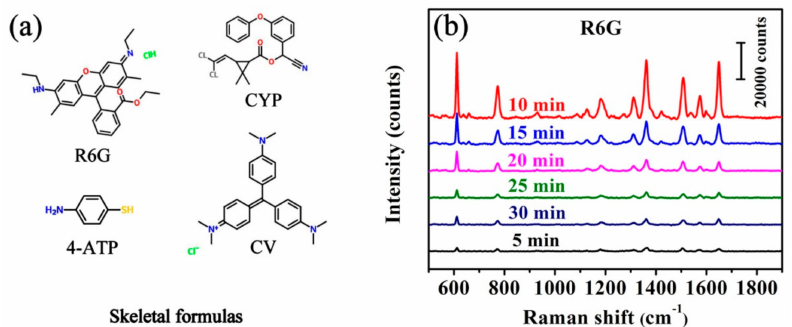
Figure 4. ( a ) The Skeletal formulas of the probe molecules used in this study; and ( b ) SERS spectra of 10 − 6 M R6G alcoholic solution absorbed onto corresponding substrates prepared at different Ag sputtering times (from 5 min to 30